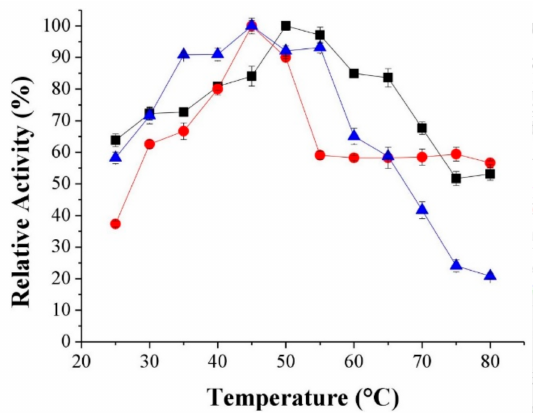
Figure 1. Effects on relative activity under various pH and temperature values. Ranging from pH 2 to Figure 2. Effects on relative activity under ranging from 25 to 80 ◦ C for lipase from Burkholderia Figure 2. Effects on relative activity under ranging from 25 to 80 °C for lipase from Burkholderia cepacia pH 10 at 37 °C for lipase from Burkholderia cepacia free (LBC) ( ■ ), lipase immobilized by covalent cepacia free (LBC), pH 7.0 ( (cid:4) ), lipase immobilized by covalent binding with epichlorohydrin onto free (LBC), pH 7.0 ( ■ ), lipase immobilized by covalent binding with epichlorohydrin onto support binding with epichlorohydrin onto support produced without ionic liquid (CBE ‐ SC) ( ● ), lipase support produced without IL (CBE-SC), pH 3.0 ( ), lipase immobilized by covalent binding with produced without IL (CBE ‐ SC), pH 3.0 ( ● ), lipase immobilized by covalent binding with immobilized by covalent binding with epichlorohydrin onto support produced with IL (CBE ‐ SIL) ( ▲ epichlorohydrin onto support produced with IL a(CBE-SIL), pH 3.0 ( epichlorohydrin onto support produced with IL a(CBE ‐ SIL), pH 3.0 ( ▲ ). ).